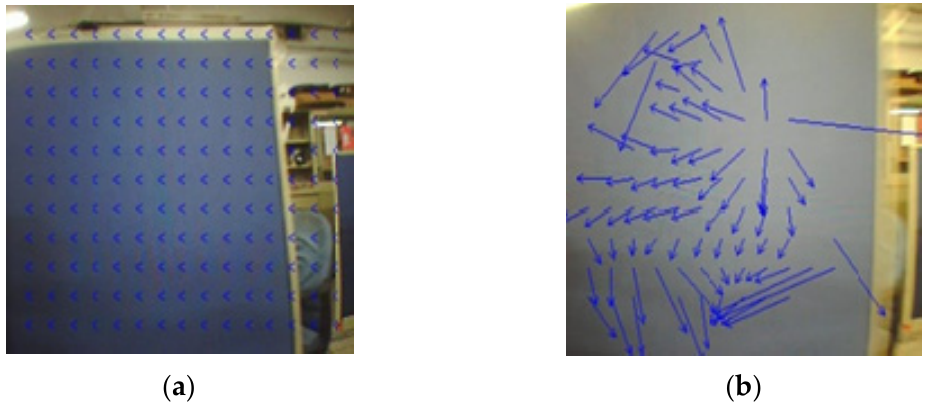
Figure 2. The tracking result of the KLT point on the blue board under the camera shake. ( a ) Uni- formly distribute points in the beginning; ( b ) tracking results after fifteen frames.